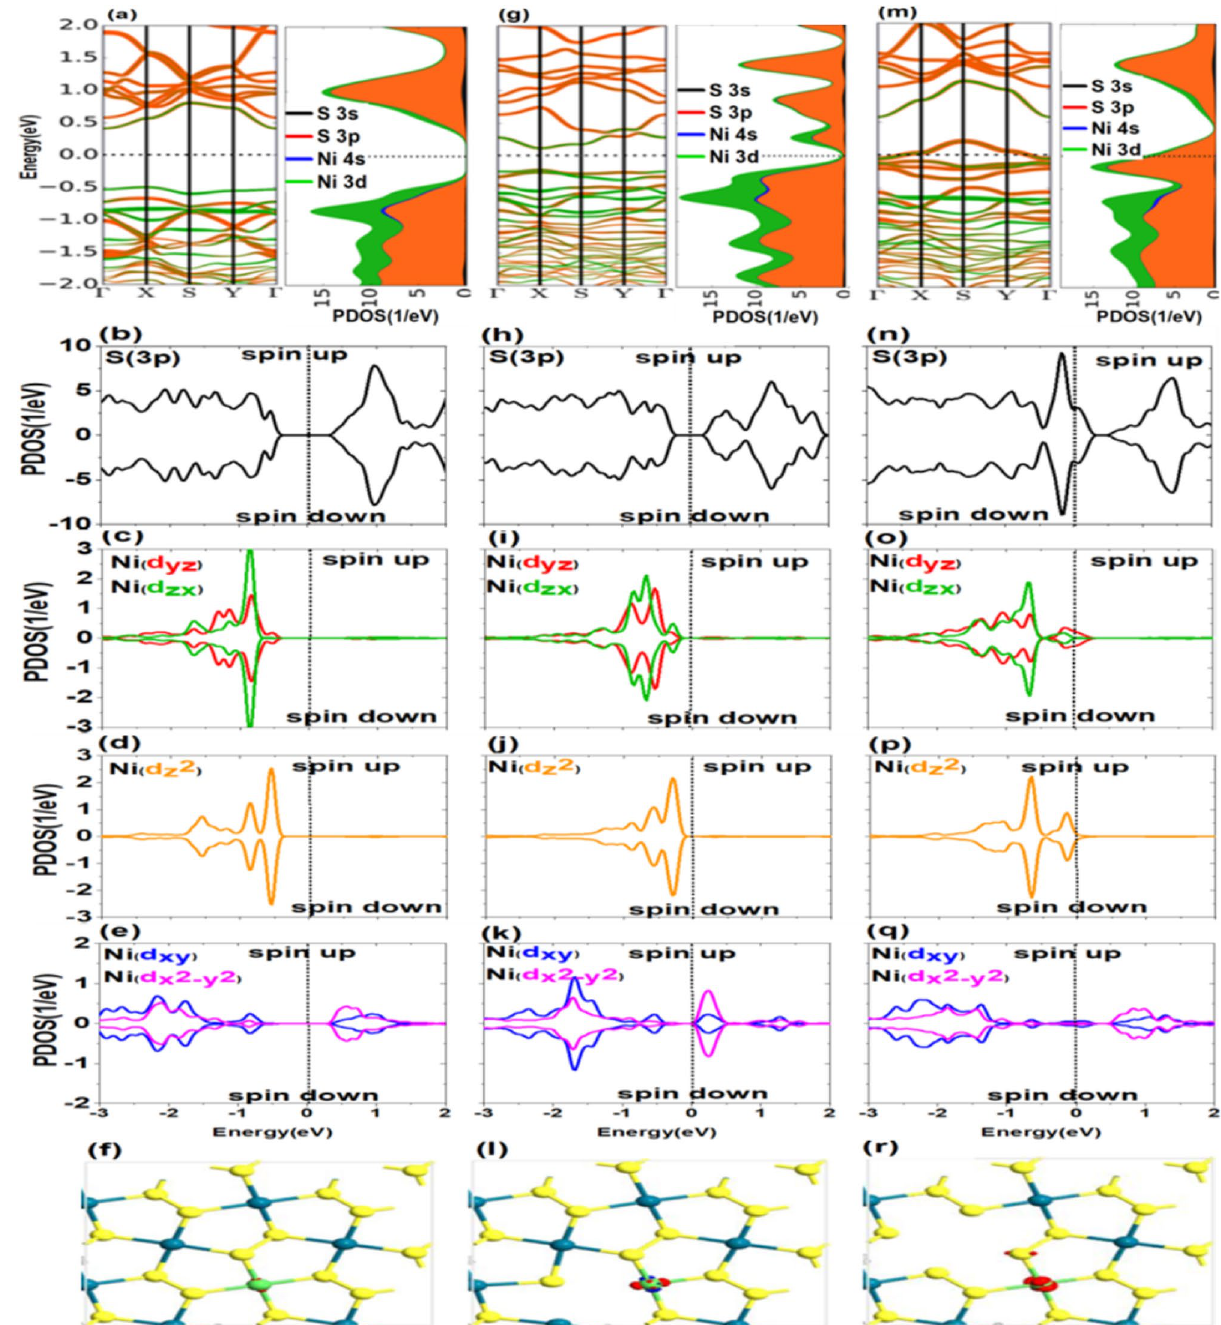
Figure 5. ( a–f ) Band structure and PDOS of p and d orbitals and spin density difference in the presence of transition metal impurity (Ni), ( g–i ) in the presence of the S vacancy, and ( m–r ) in the presence of the Pd